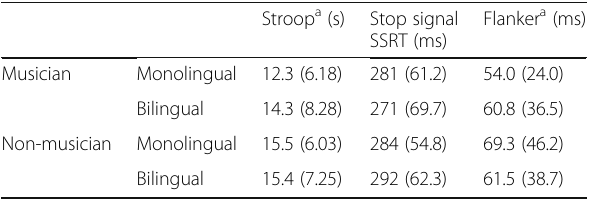
Table 3 Mean reaction times (SD) on inhibitory control measures by participant group Stroop a (s) Stop signal SSRT (ms)